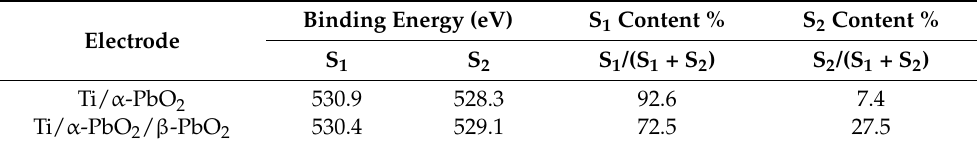
Table 1. Analysis of O 1s peaks from electrodes.